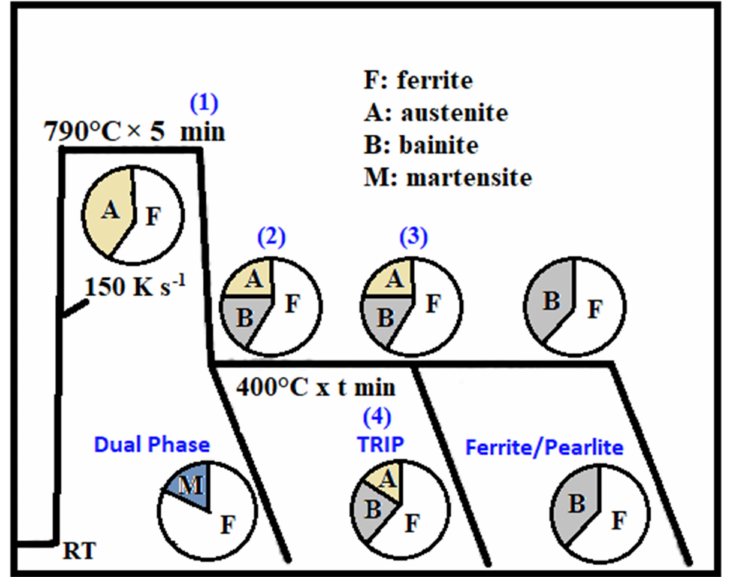
Figure 2. Mechanism of retained austenite formation during heat treatment of TRIP and DP steels